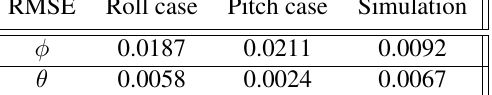
Table 1: RMSE values for the experimental roll and pitch experiments, and for a simulated dataset using the EKF on SO (3) formulation